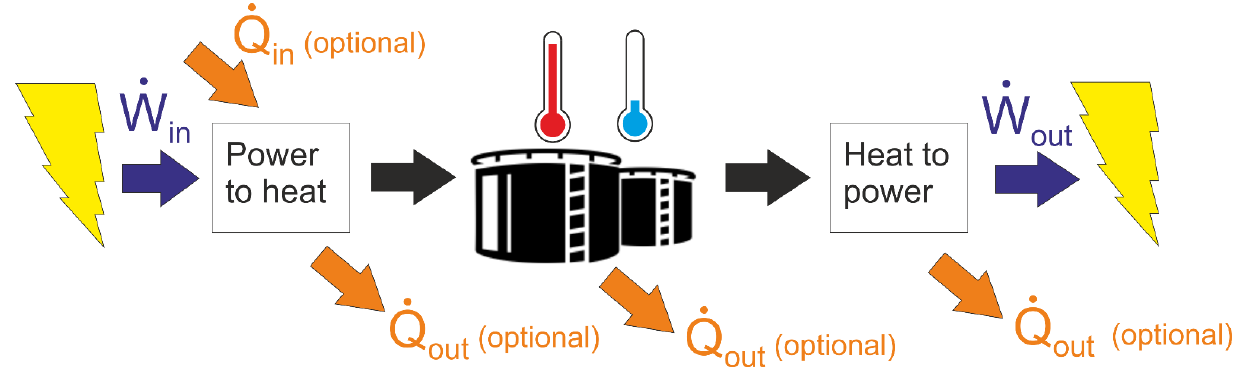
Figure 2. General principle of Carnot battery systems.